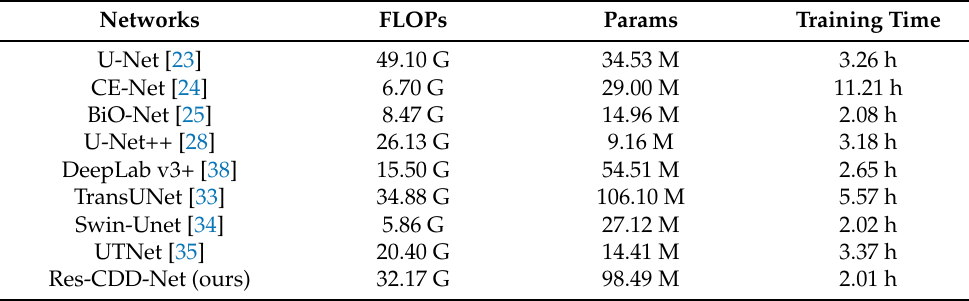
Table 11. Network complexity analysis of Res-CDD-Net and other